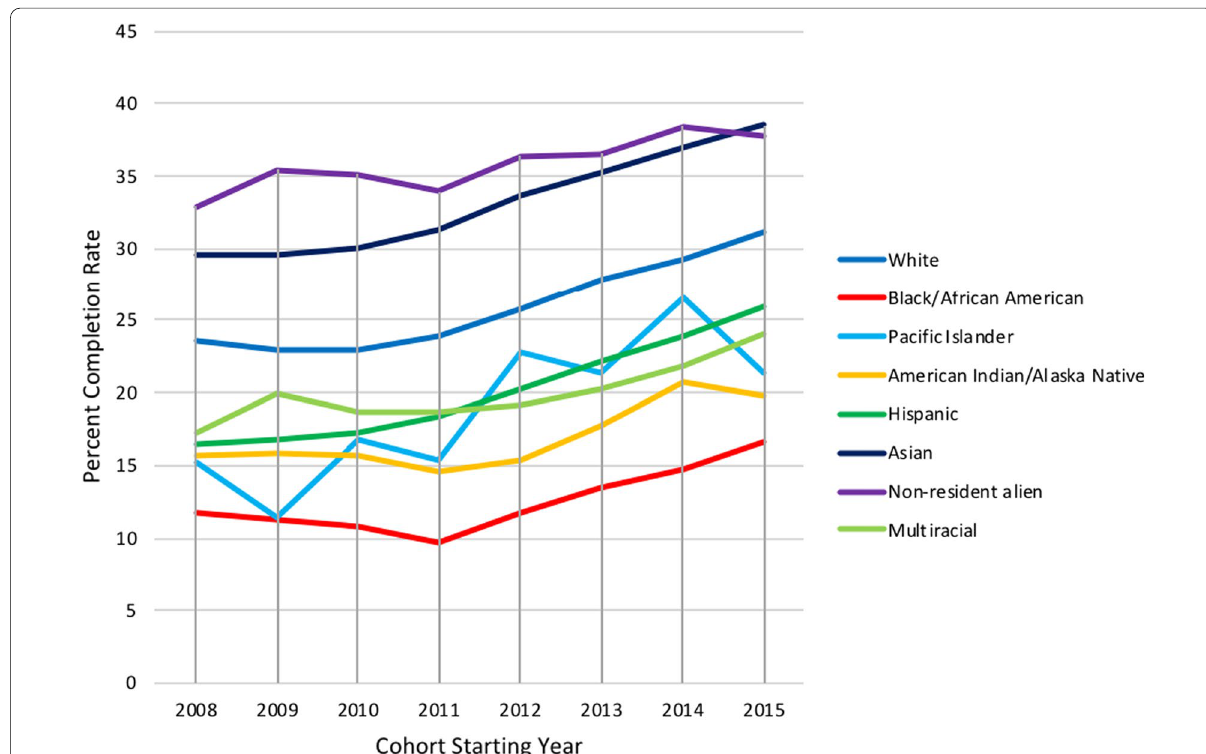
Fig. 1 NCES/IPEDS—graduation/completion rates over time. 2008 was the first year Asian and Pacific Islanders were disaggregated and results from Multiracial category (“Two or more races”) were